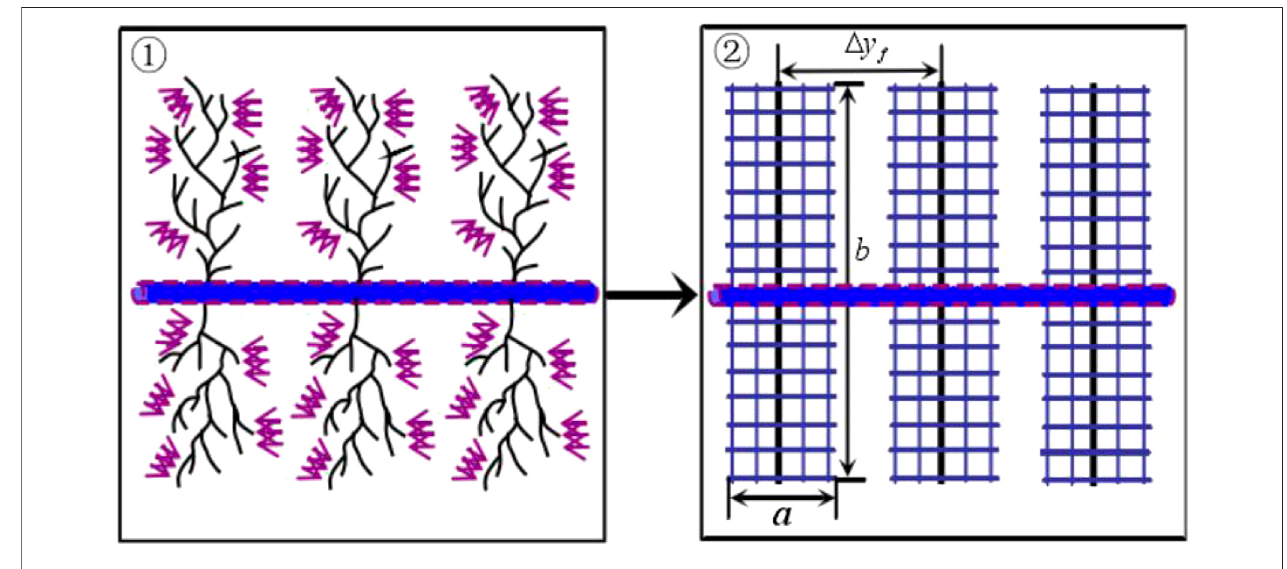
FIGURE 1 | Schematic diagram of geometric